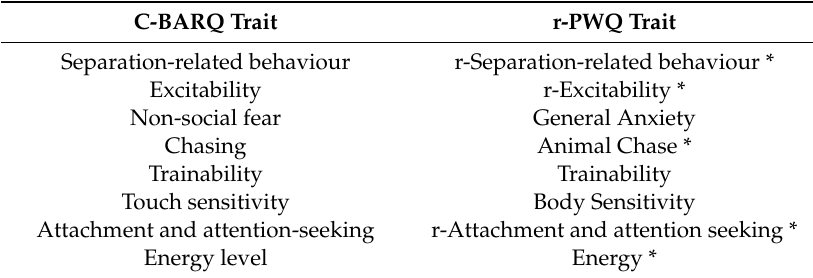
Table 2. C-BARQ and r-PWQ traits that were directly compared throughout the study. C-BARQ Trait r-PWQ Trait Separation-related